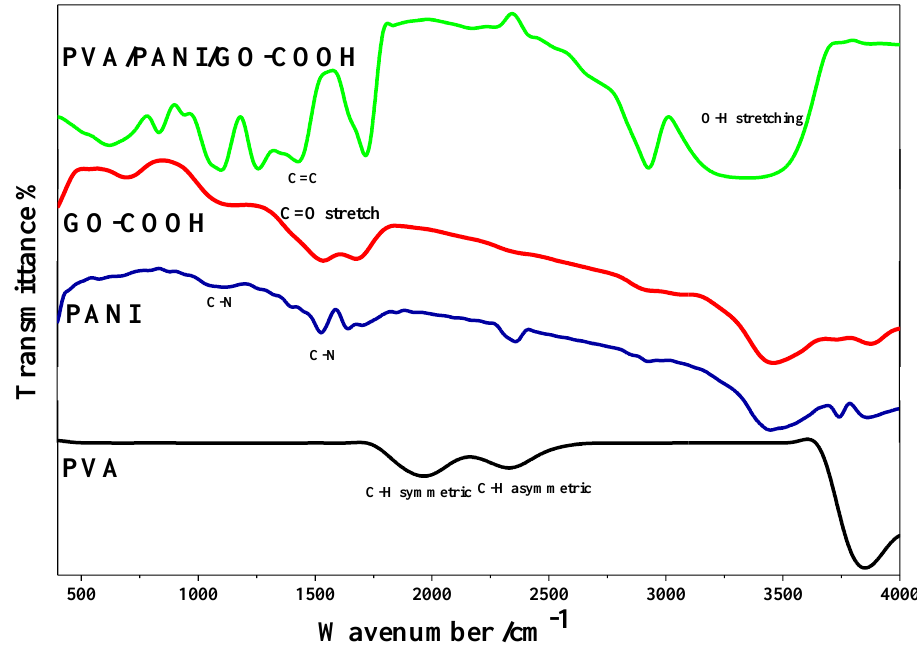
Figure 2. FTIR spectra of PVA, PANI, GO-COOH, PVA/PANI/GO-COOH composite coating.